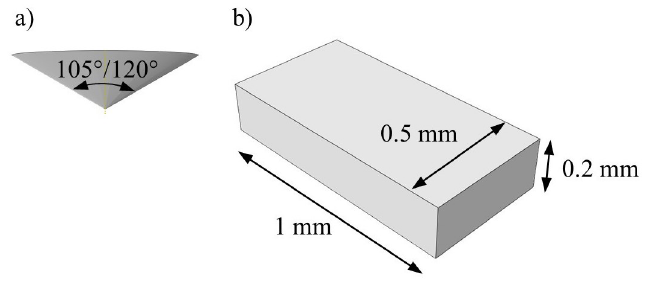
Figure 10. Model dimensions of rigid tool ( a ) and deformable workpiece ( b ) of the 3D scratch model.